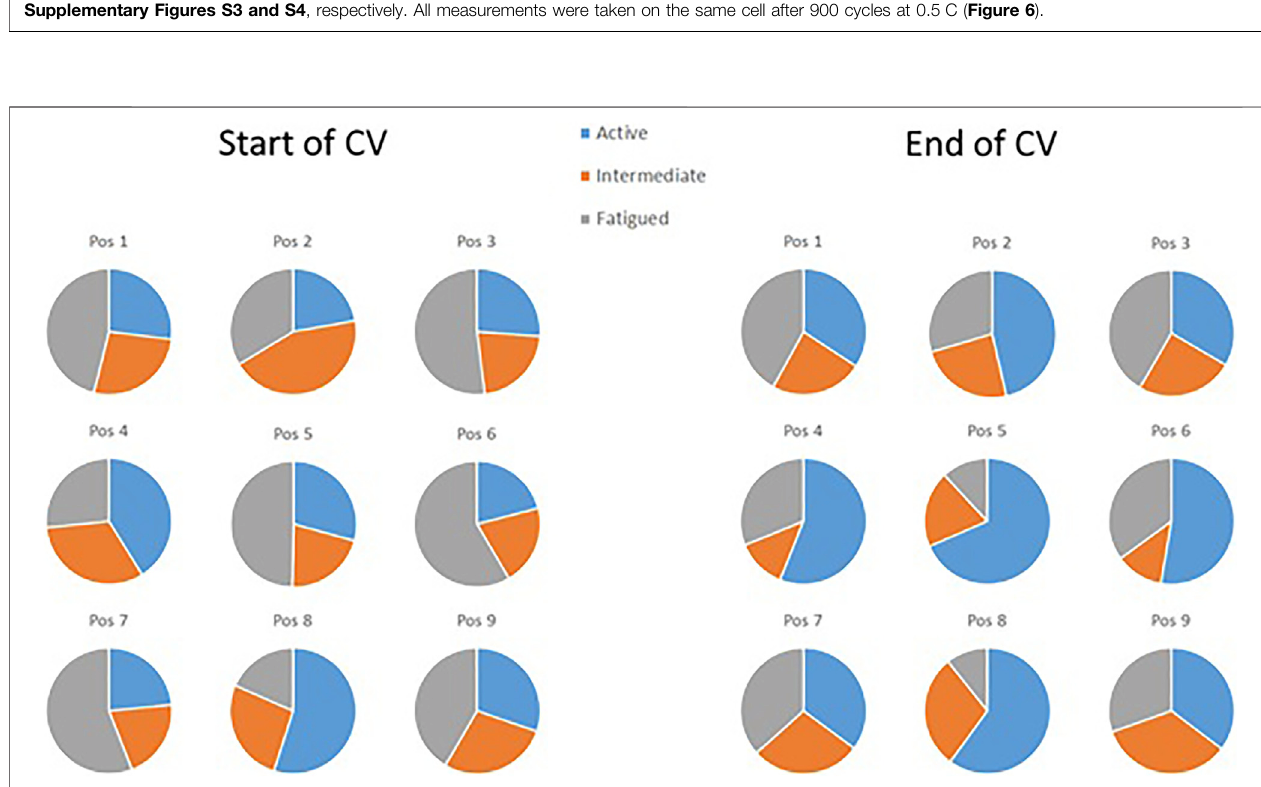
FIGURE 8 | The ratios of the active, intermediate, and fatigued phases for each position at the start of the constant voltage (CV) hold and at the end of the CV section. The cell was cycled at C/10 (based on fresh capacity). SXRD raw, calculated, and residual data plots for these results are shown in Supplementary Figures S4 – S21